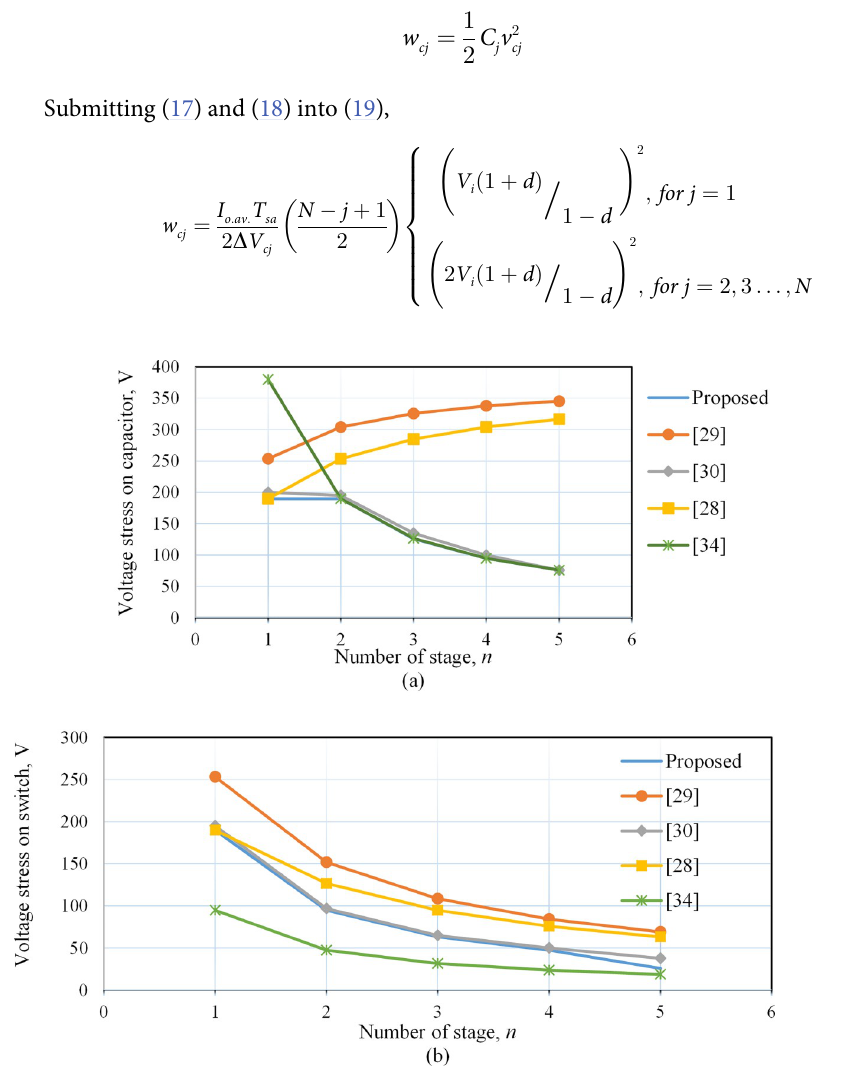
Fig 6. Voltage stresses on different devices for the proposed converter and others at duty cycle d = 0.5 and output voltage at V o = 380V. Thus, the required input voltage decreases as the number of stage increase. (a) Capacitor voltage stress. (b) Switch voltage